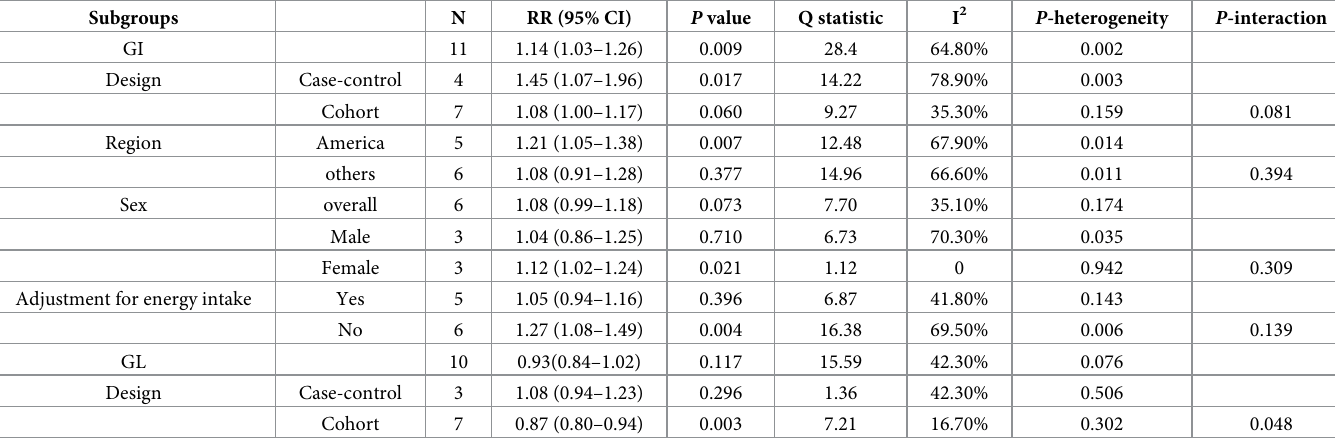
Table 3. Subgroup analyses of GI and GL and lung cancer risk, high vs. low